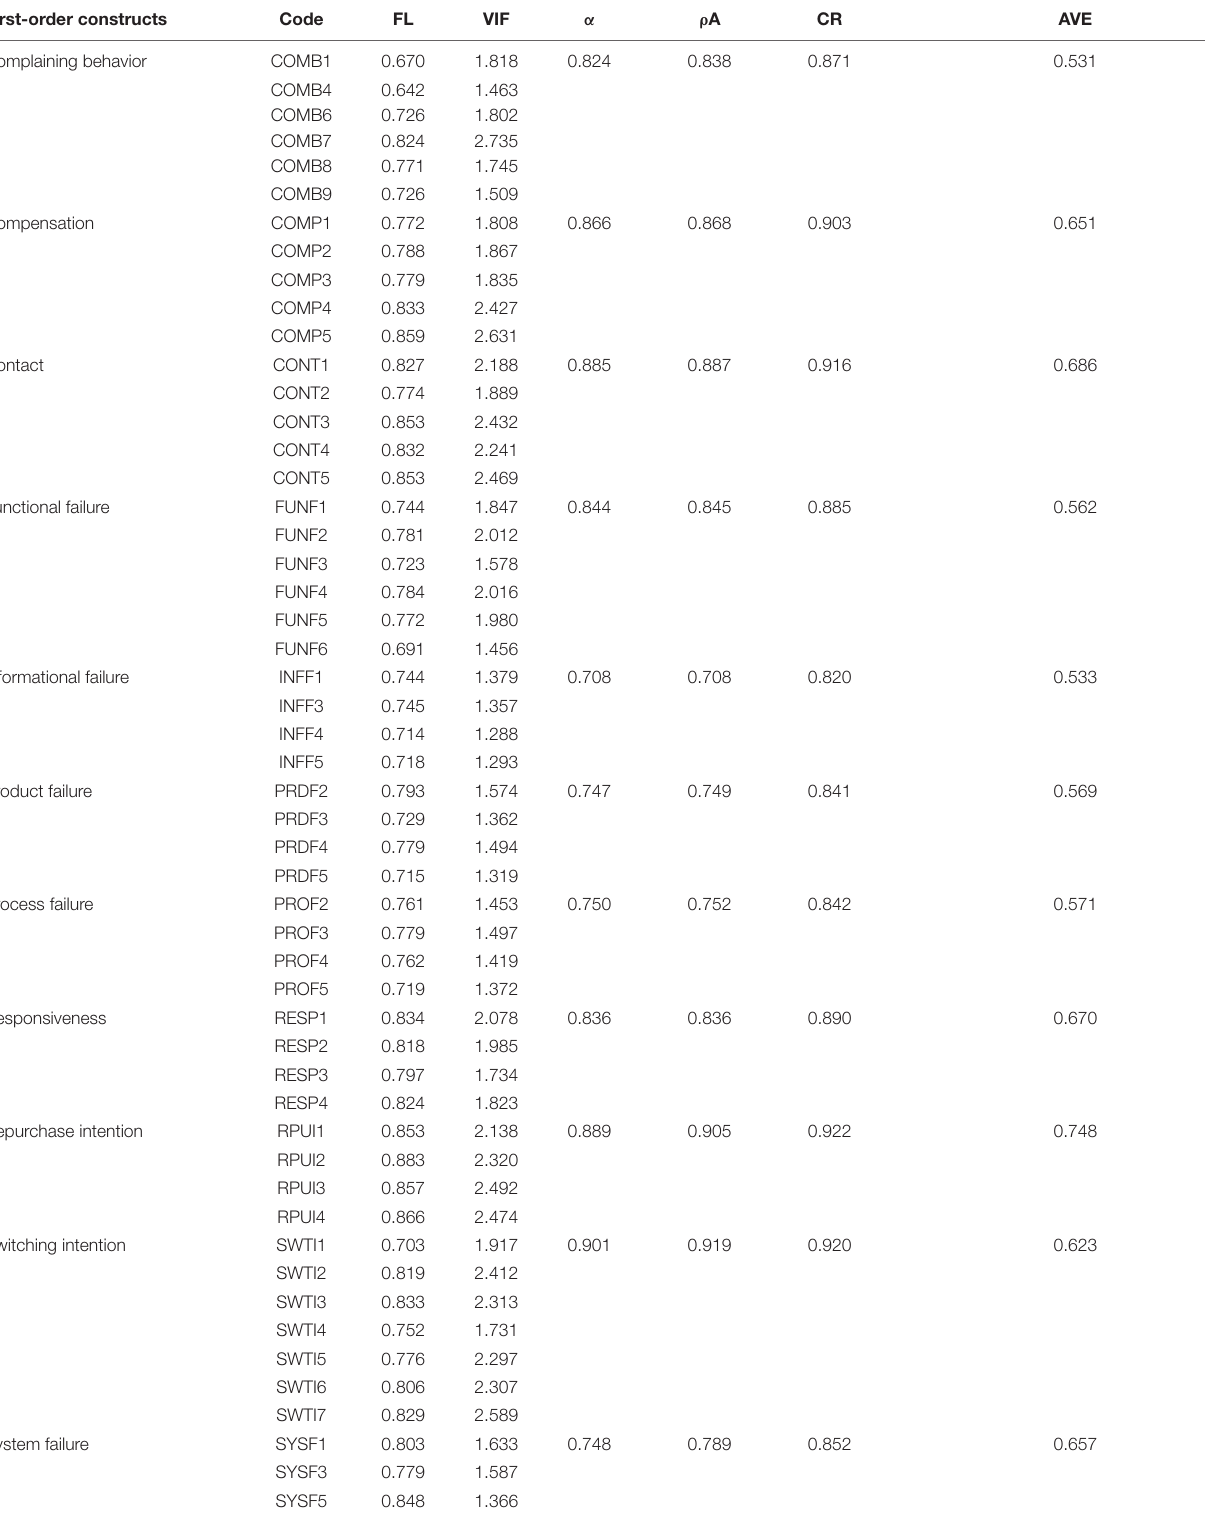
TABLE 4 | Measurement